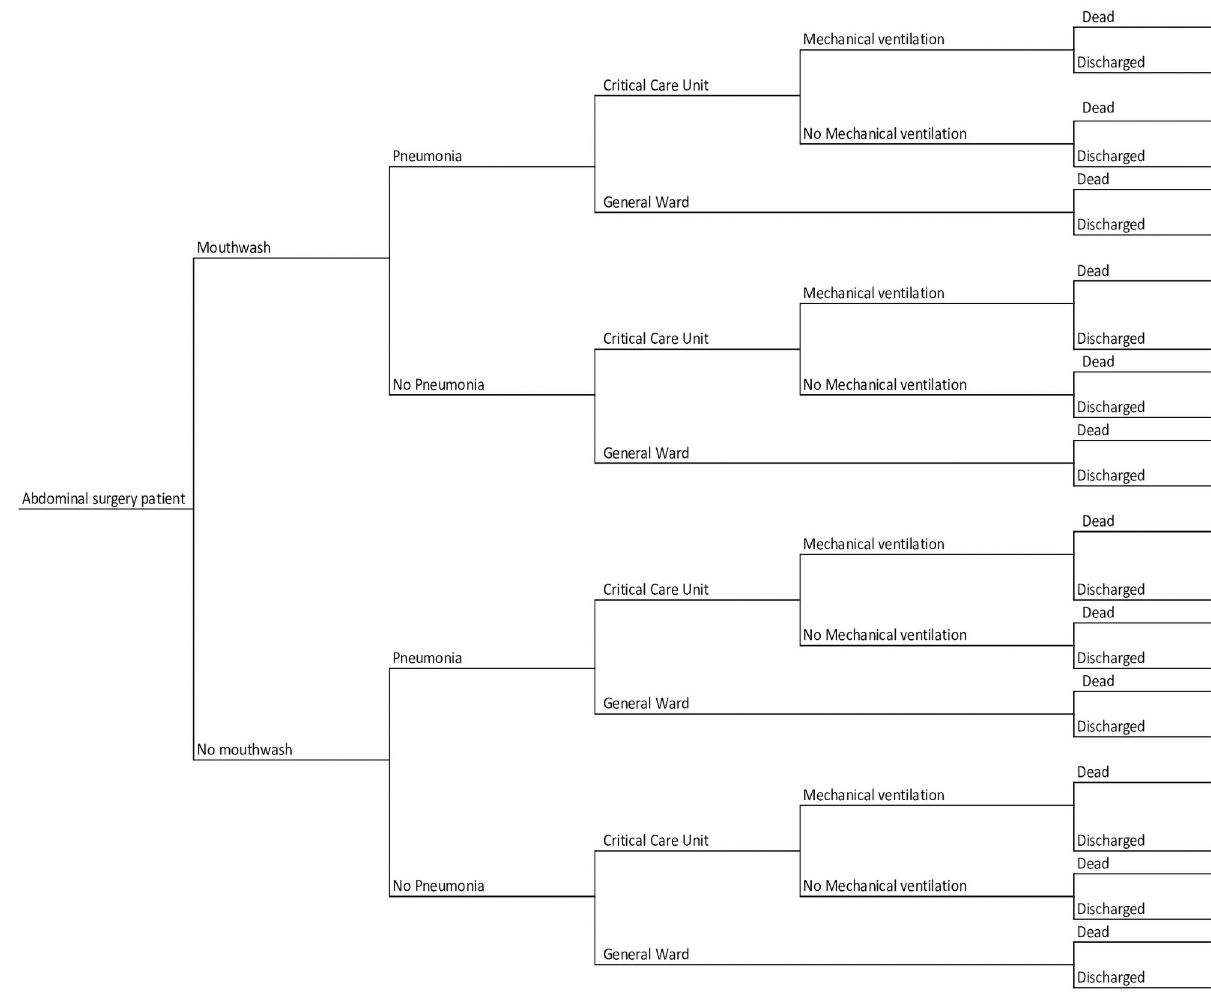
Fig 1. Abdominal surgery patient